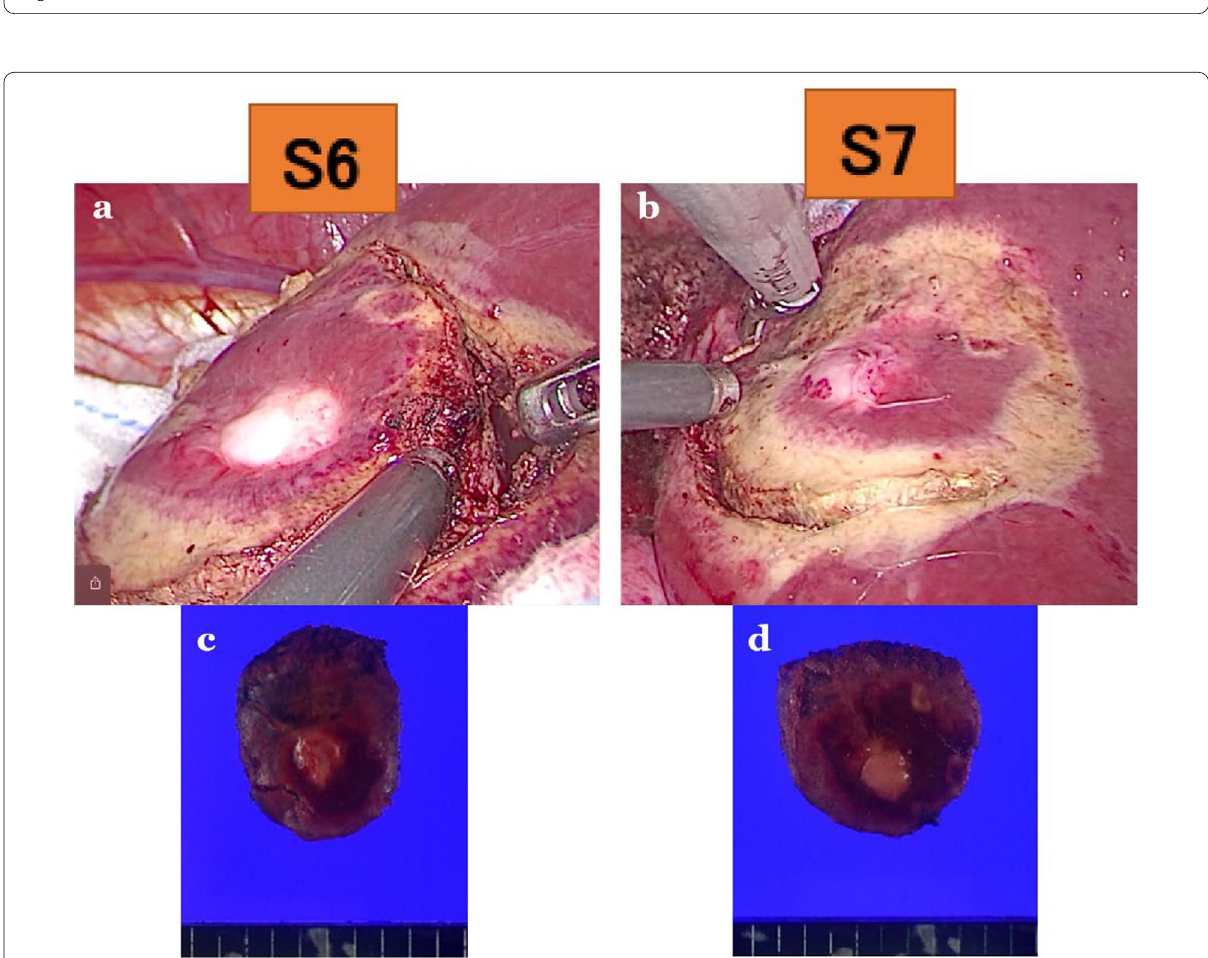
Fig. 2 Intraoperative views of laparoscopic partial hepatectomy and liver specimens. a Metastatic tumor in segment 6. b Metastatic tumor in segment 7. c Metastatic tumor in segment 6. d Metastatic tumor in segment